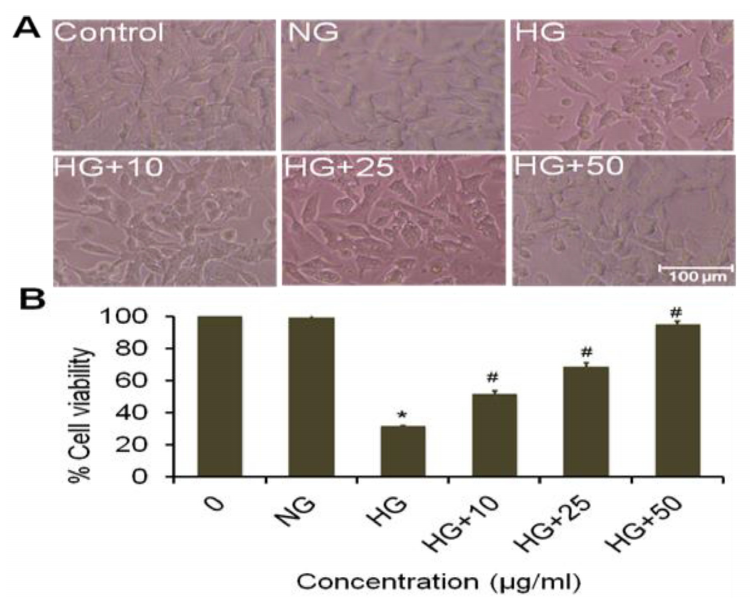
Figure 5. In vitro neuroprotective effects of WT extract against mammalian neuroblastoma SHSY5Y cells ( A ) Photomicrograph of SHSY5Y cell line treated with NG, HG and 10 to 50 µg/mL concentration of WT extract ( B ) Dose-response effects of NG, HG and WT extract at different concentrations on SHSY5Y cell line for 24 h. Photomicrographs were taken with an inverted phase contrast microscope. Scale bar = 100 µm. All the alues are expressed as mean ± SEM. * p < 0.05, HG vs NG; # p < 0.05, as compared to high glucose.